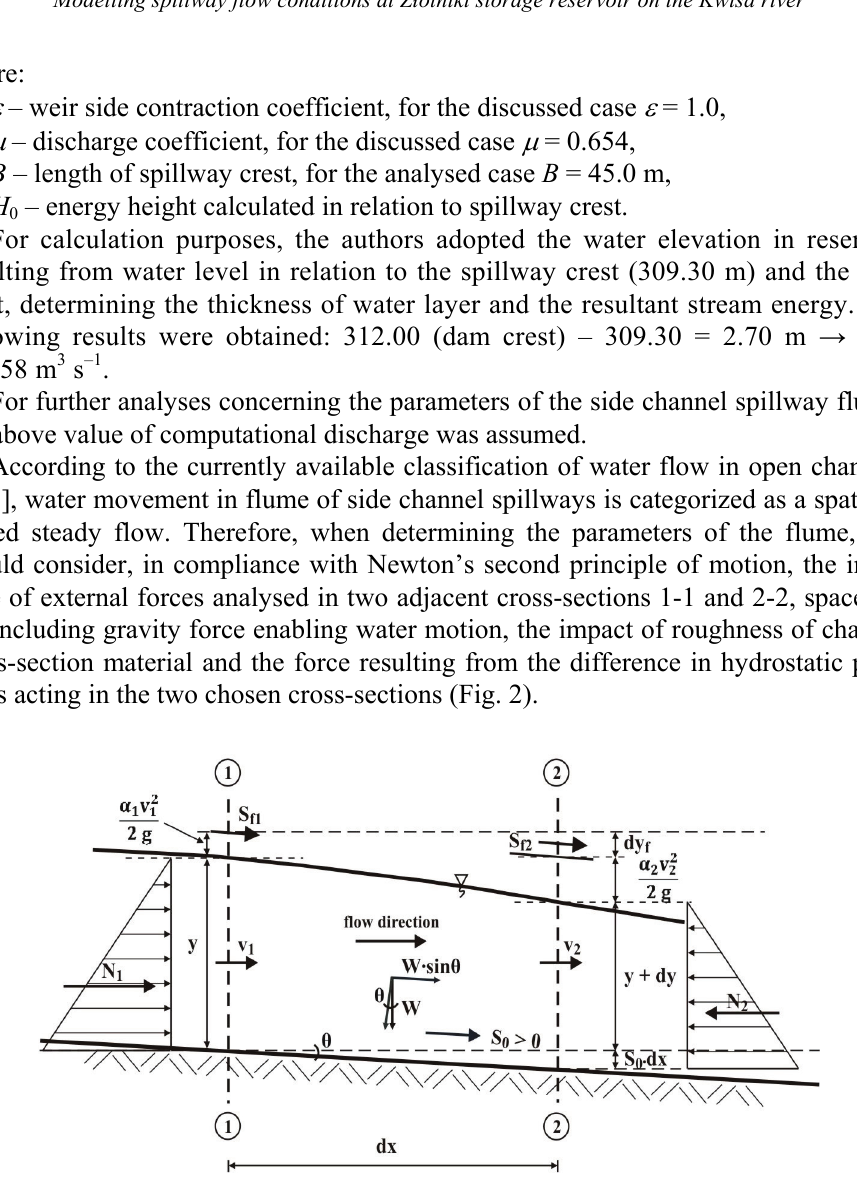
Fig. 2. Computational dimensioning scheme of a spillway